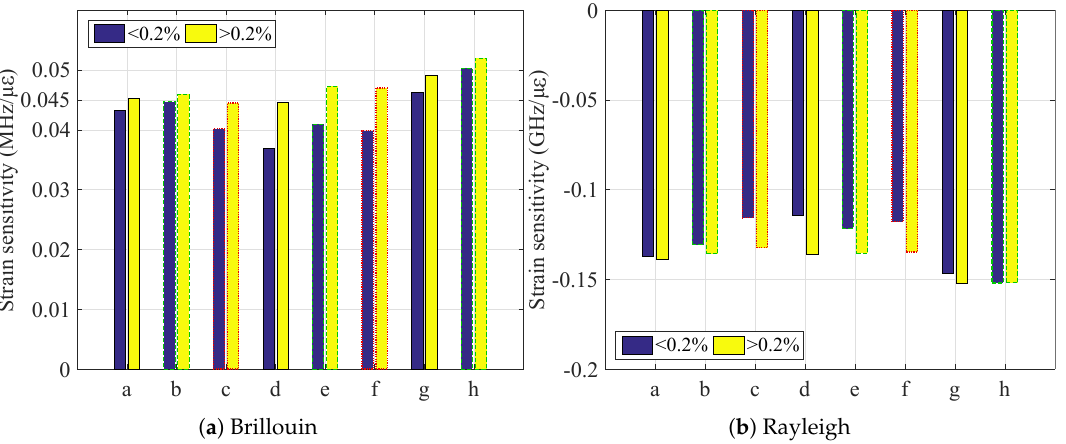
Figure 7. Strain sensitivity coefficients for different linear fittings: “<0.2%” and “>0.2%” represent the fit done considering only the values before or after 2000 µε . The different contours of the bars define the type of sample: the black and straight line are the standard samples, the green and dashed the custom not irradiated, and the red and dotted the custom irradiated.